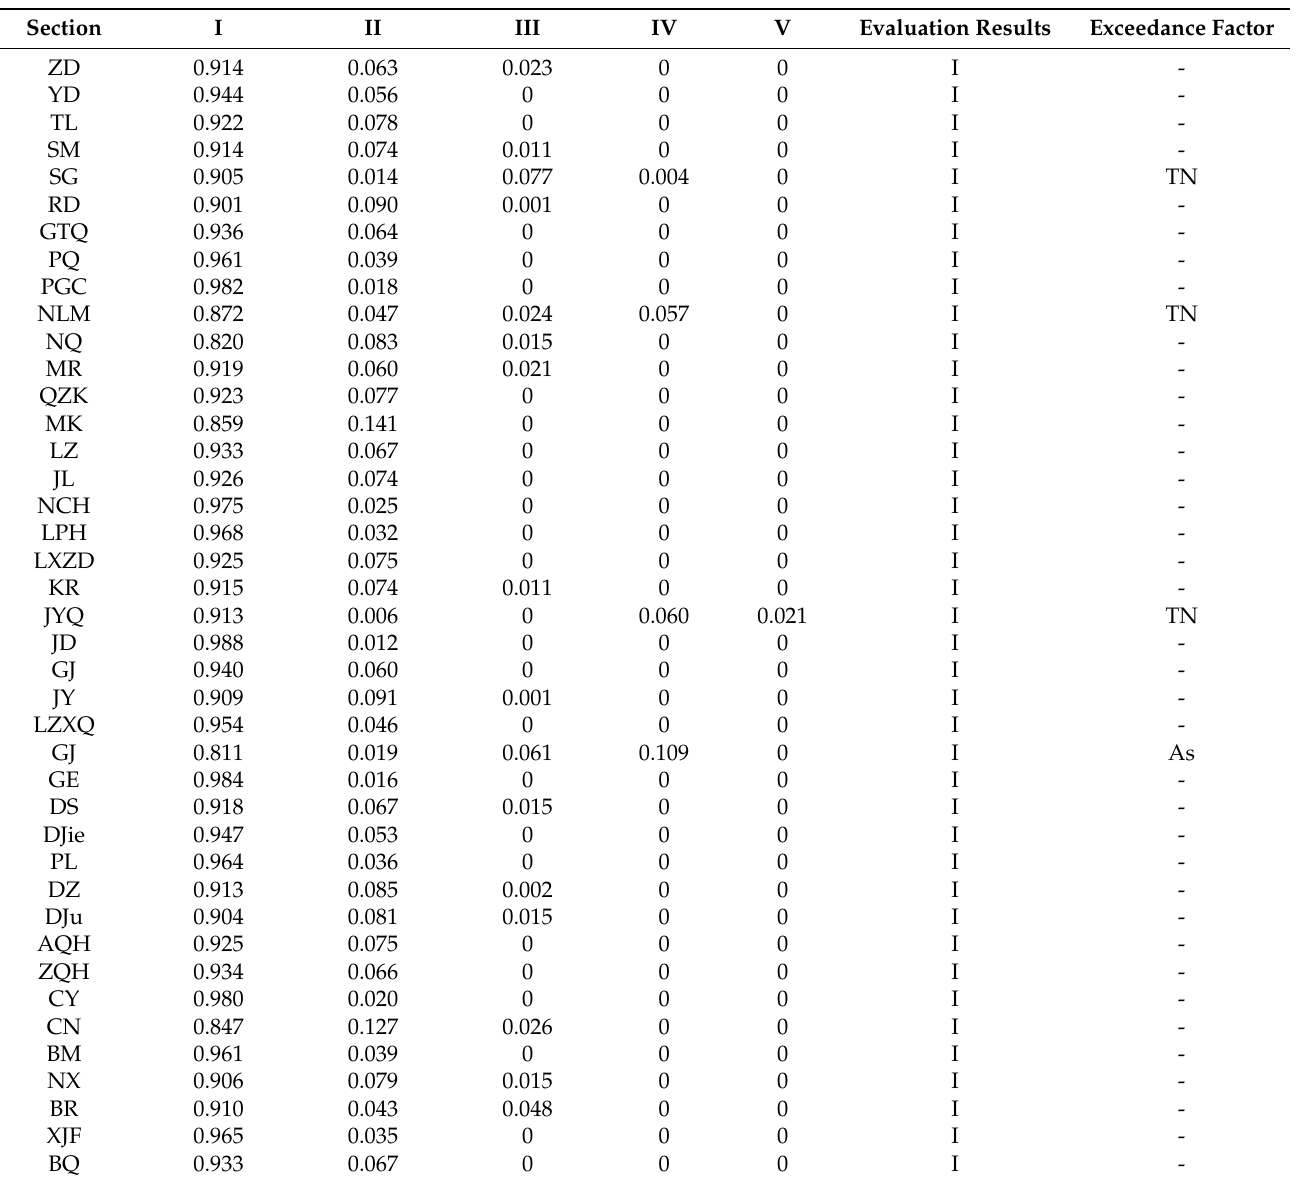
Table 5. Results of entropy method–fuzzy evaluation for water